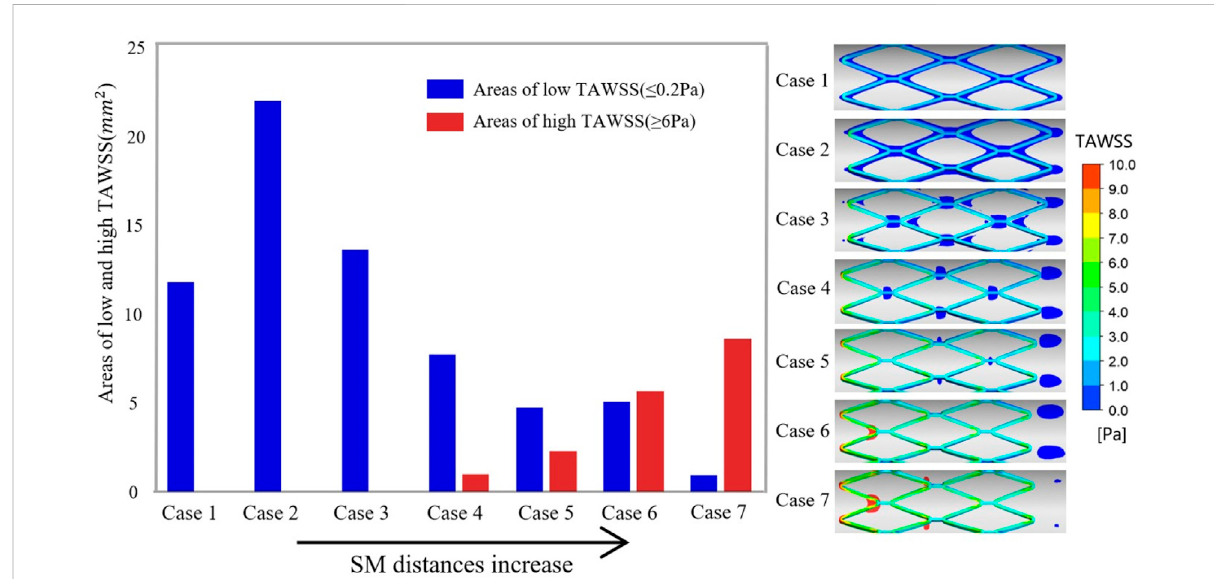
FIGURE 4 RightpanelillustratesthecompleteTAWSScontoursonthestentsurfaceandtheregionoflowTAWSS( ≤ 0.2 Pa)andhighTAWSS( ≥ 6 Pa)onthe vessel wall are colored blue and red, respectively. The histogram shows the area of adverse TAWSS from case 1 to case 7 with the increasing SM distance. The areas correspond to the highlighted region of TAWSS on the vessel wall. TAWSS, time-averaged wall shear